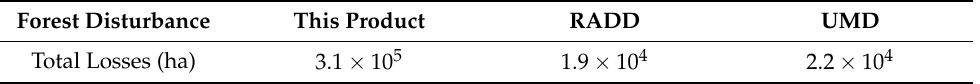
Table 2. Area of pixels containing forest change in Gabon for the year 2020 estimated by this product (canopy cover loss from S-1), the Radar for Detecting Deforestation (RADD) product (disturbance alerts from S-1), and the University of Maryland (UMD) product (forest loss from Landsat). Forest Disturbance This Product RADD UMD Total Losses (ha)